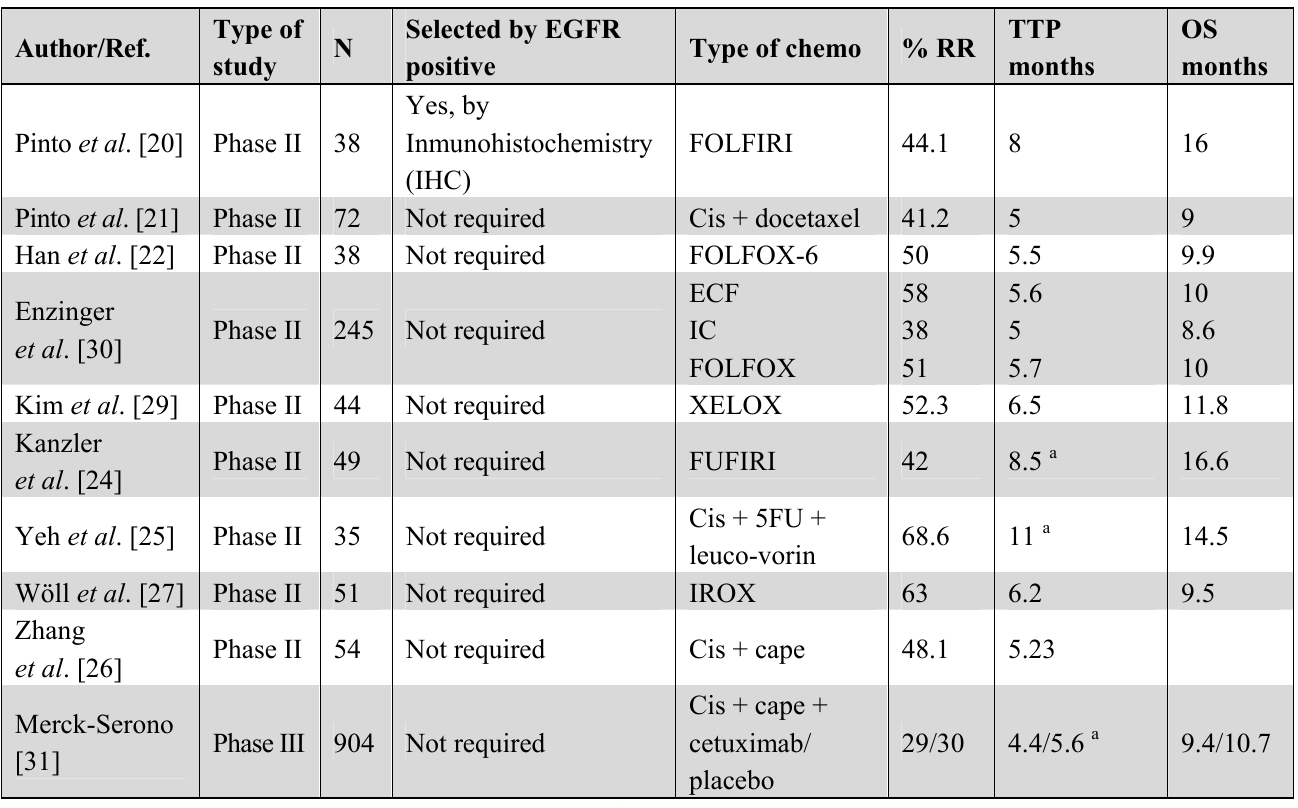
Table 2. Phases II and III of cetuximab combined with chemotherapy for advanced GC in first-line